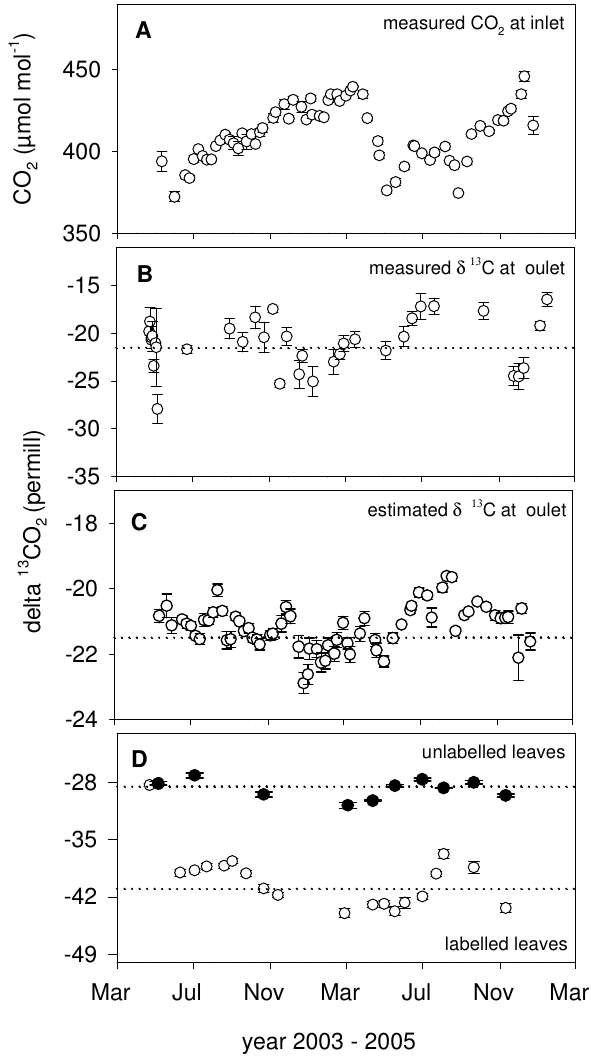
Fig. 2. (A) Measured CO 2 concentration at the canopy enclosure inlet, (B) δ 13 C at canopy enclosure outlet, (C) estimated δ 13 C of CO 2 supplied to canopy enclosure inlet and (D) δ 13 C of labelled C 3 grass leaves during experimental period (April 2003 to March 2005) and of unlabelled C 3 control grasses grown outdoors. Data are means ( ± SE) of 16, 14 and 4 replicates for labelled C 3 and un- labelled C 3 controls, respectively. Dotted lines represent the mean δ 13 C values of supplied CO 2 ( − 21.5‰) (A, B) and of C 3 leaves of labelled ( − 41.4‰) and unlabelled control ( − 28.7‰) plants (D).